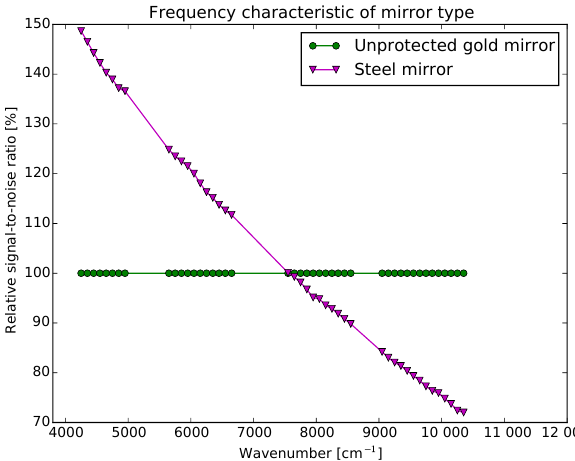
Figure 13. Frequency characteristic of the stainless steel mirror evaluated at the reference points defined in Fig. 11. The frequency response was normalised with respect to the original gold-coated mirror shortly after installation. Thus the green circle were derived from S 1 / S 1 and the magenta triangles from S 4 / S 1 (from Table